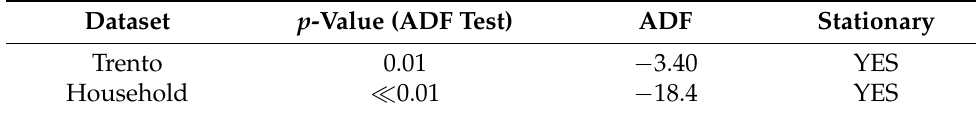
Table 2. ADF Test